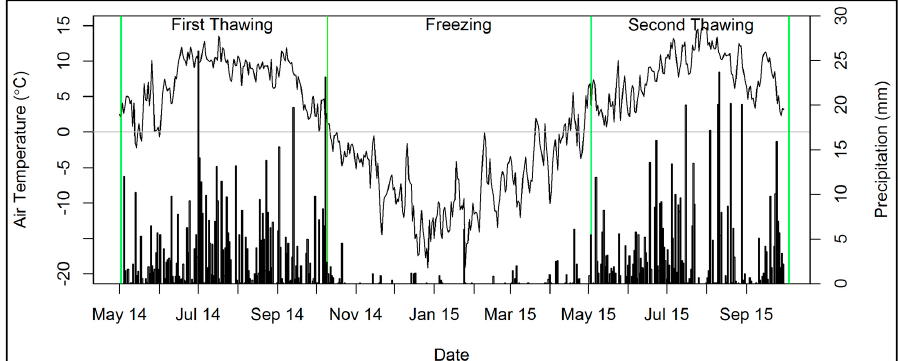
Figure 2. Time series showing the daily air temperature (curve) and precipitation (bar chart) observations at the KMP near the slope (94°1 ′ E, 35°36 ′ N) during 1 May 2014 to 30 September 2015. The four green lines denote the dates of the four TLS measurements. KMP: Kunlun Mountain Pass. The slope can be divided into: (a) the upper slope; (b) the lower slope; and (c) the base. The areas of the three zones relative to the total area of the slope were 39%, 28%, and 33%, respectively (Figure